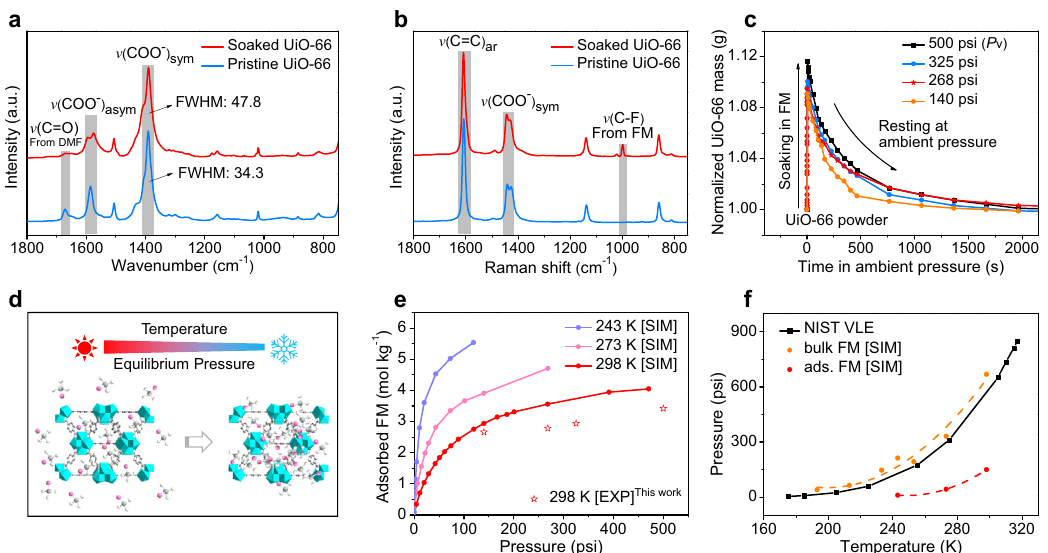
Fig. 3 Interaction and adsorption behavior of FM in UiO-66. FT-IR ( a ) and Raman spectrum ( b ) of UiO-66 before and after soaking in the lique fi ed FM. c Mass change of lique fi ed FM-soaked UiO-66. d Schematic showing the adsorption behavior of FM in UiO-66 at different conditions. e Simulated (SIM) adsorption isotherms of UiO-66 con fi ned FM at different temperatures and experimental (EXP) results at 25 °C. f Phase transition comparison between bulk FM taken from NIST database, simulated (SIM) bulk FM and simulated (SIM) adsorbed (ads.) FM in UiO-66 systems, where the orange and the red points represent as the phase transitions of bulk FM and adsorbed FM (ads. FM) in UiO-66,